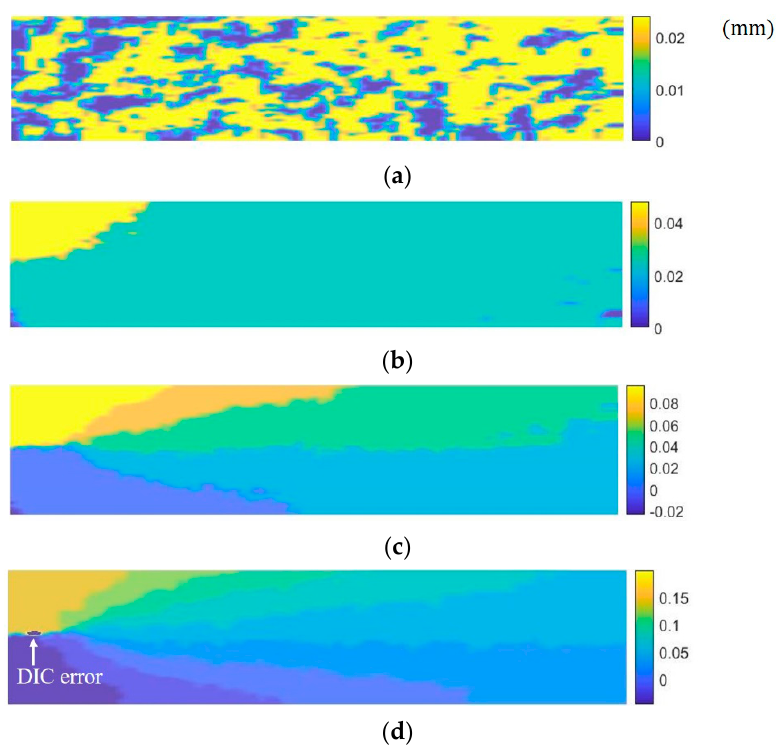
Figure 10. Digital image correlation (DIC) analysis results using the proposed algorithm under the uniaxial tensile loads of: ( a ) 0.2, ( b ) 1.0, ( c ) 1.4 and ( d ) 1.7 mm.